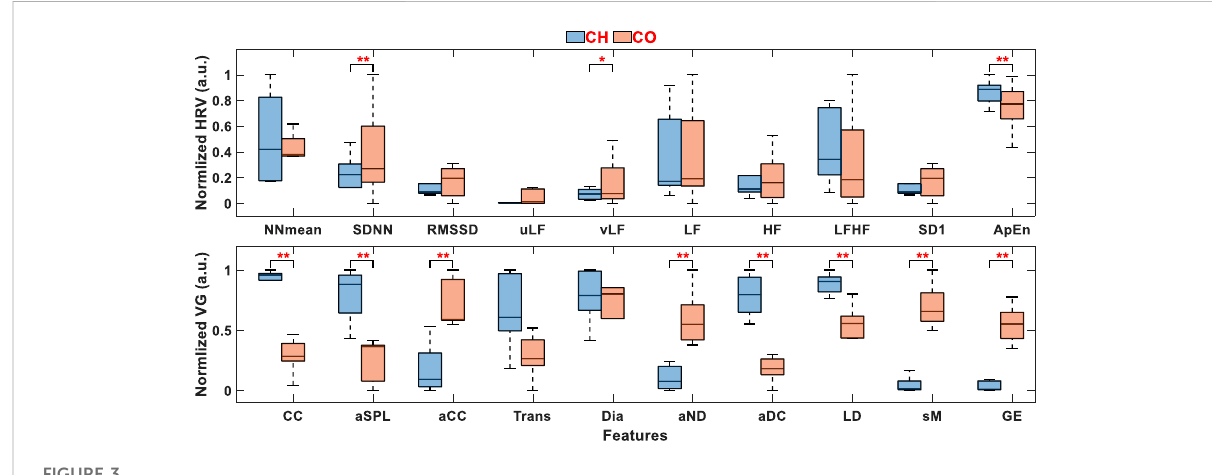
FIGURE 3 HRV and VG features between CH and CO. “ * ” stands for signi fi cant difference between two groups ( p < 0.05) and “ ** ” stands for extremely signi fi cant difference ( p < 0.01). ANS Analysis Performance of VG on UST